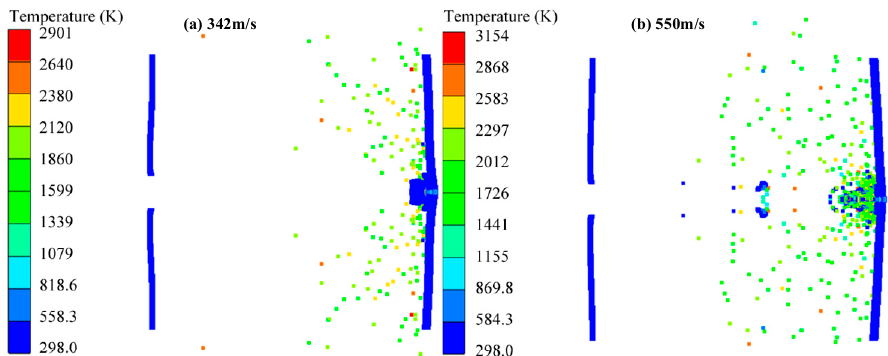
Figure 11. The temperature distribution at impact on the rear plate.